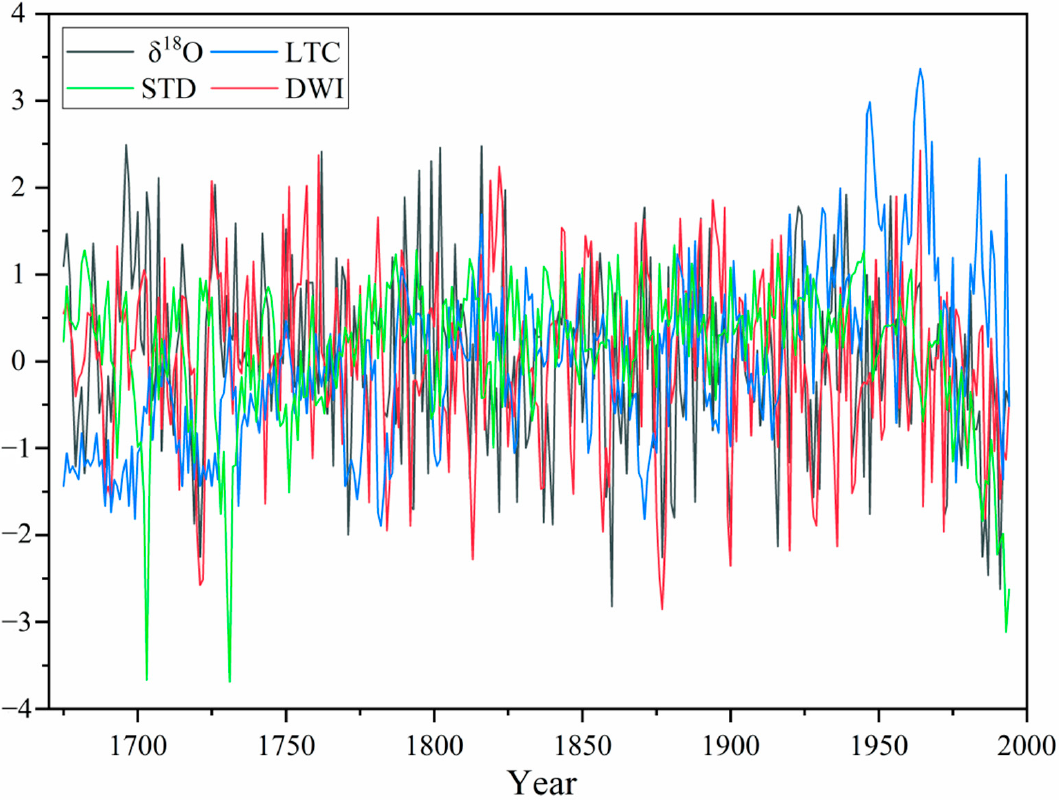
Figure 3. Four standardized individual series used for the principal component analysis. δ 18 O means tree-ring δ 18 O in Luya Mountain of Shanxi Province (Li [21]); LTC means the layer thickness of stalagmites in Beijing’s Shihua cave (Tan [22]); STD indicates tree-ring width chronology in Shandong Province (Liu [20]); DWI indicates regional dryness / wetness index based on historical literature and geographic information system over whole the North China Plain (Shen [23]).